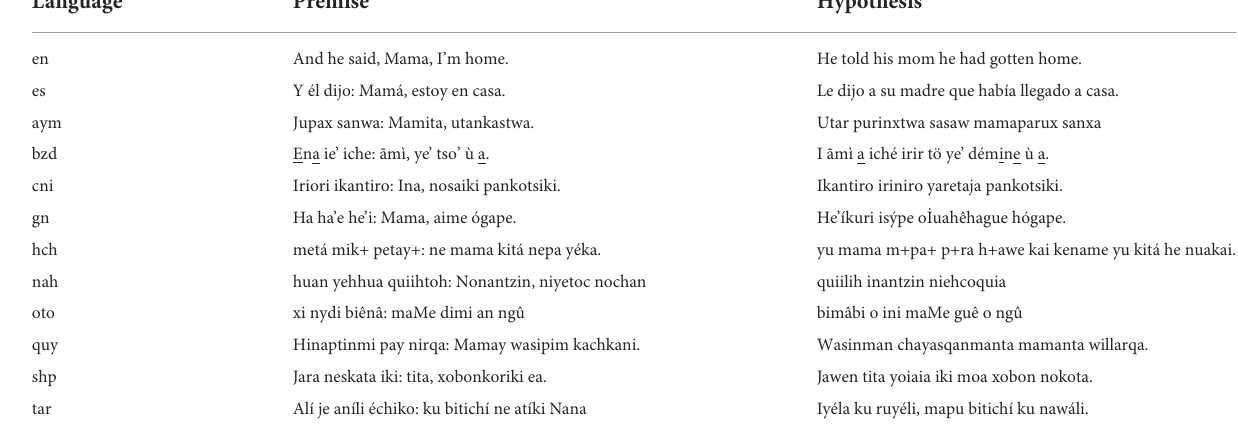
TABLE 2 A parallel example in AmericasNLI; label: entailment . Language Premise